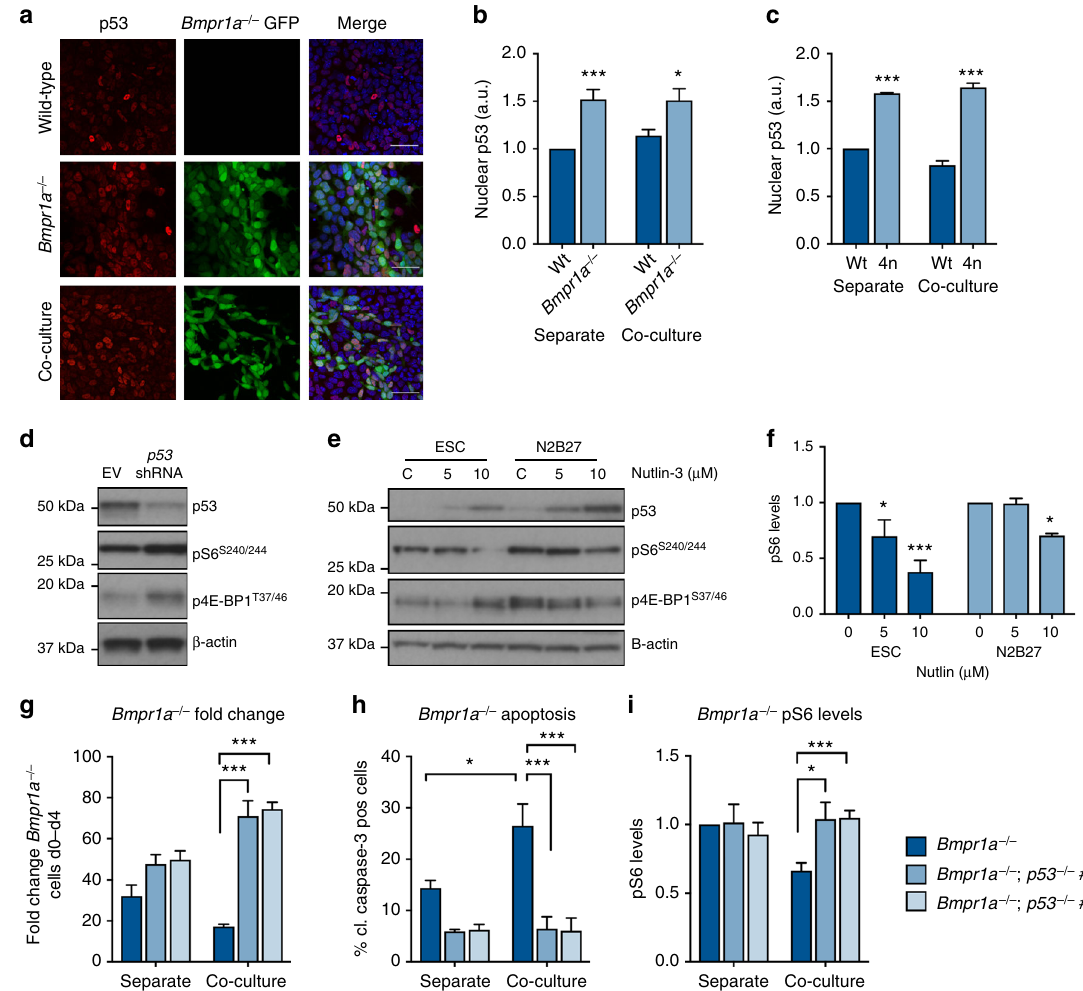
Fig. 4 p53 is upstream of mTOR pathway repression during ESC differentiation. a Total p53 levels in wild-type and Bmpr1a − / − cells in separate and co- culture at day 3 in competition were assessed by immuno fl uorescence and nuclear p53 levels were quanti fi ed ( b ). Scale bar = 50 μ m. c Total p53 levels in wild-type and 4n cells in separate and co-culture were assessed by immuno fl uorescence and quanti fi ed. d Wild-type cells were infected with shRNAs targeting p53 and levels of mTOR pathway activity were assessed by western blot. e Wild-type cells were treated with p53 activator Nutlin-3a for 8 h and levels of mTOR pathway activity were assessed by western blot and quanti fi ed ( f ). g Fold change, apoptosis ( h ), and pS6 levels ( i ) in Bmpr1a − / − and Bmpr1a − / − ;p53 − / − (two independent clones) cultured separately and with wild-type cells (co-culture) from d0 – d4. Apoptosis levels of Bmpr1a − / − ; p53 − / − were compared to Bmpr1a − / − ;Cas9 as previously shown (Fig. 3a) n = 3 for all studies; error bars denote SEM. * p < 0.05, ** p < 0.01 and *** p <